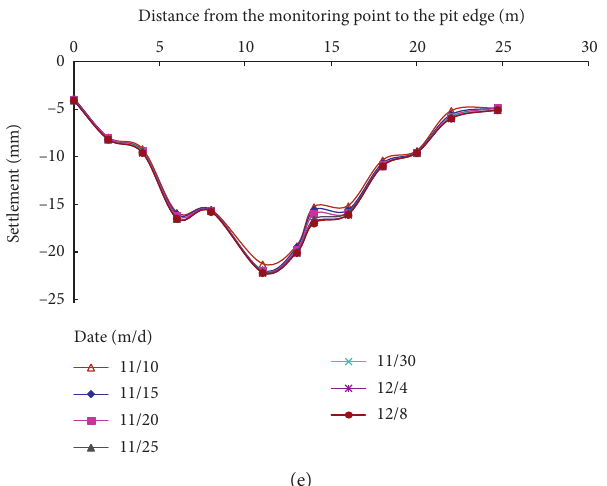
Figure 10: Variation curve of surface settlement during foundation pit excavation. (a) The first stage. (b) The second stage. (c) The third stage. (d) The fourth stage. (e) The fifth